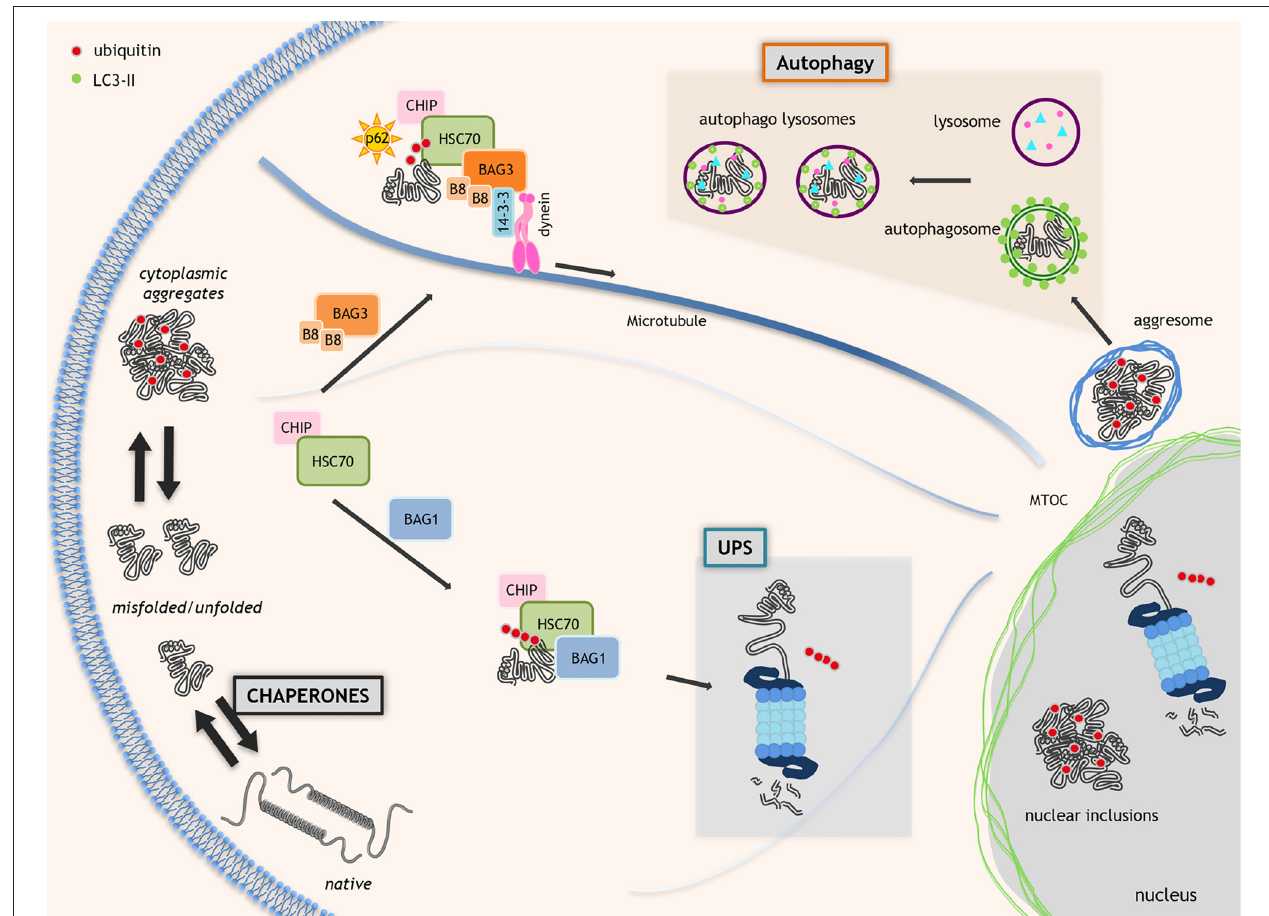
FIGURE 1 | Proteostasis in neurodegenerative disorders. Molecular chaperones assist proteins to acquire the proper folding. When folding fails, the chaperones allow the ubiquitination and route misfolded proteins to degradative systems. This process is mediated by the HSC70-CHIP complex that interacts with nucleotide exchange factor (NEF)/BCL2-associated athanogenes (BAGs; HSC70 co-chaperones). BAG1 routes misfolded proteins to ubiquitin proteasome system (UPS). Alternatively, BAG3 and specific chaperone heat shock protein B8 (HSPB8; B8 in the figure) promote the degradation of HSC70 substrates via autophagy. The HSC70-CHIP interaction with BAG1 inhibits the HSP70 chaperone activity and allows misfolded proteins polyubiquitination by HSC70-binding co-factor CHIP resulting in misfolded proteins degradation via UPS. BAG3 interacts with dynein and 14-3-3 protein moving misfolded proteins to microtubule organization center (MTOC) where aggresomes are assembled. Polyubiquitinated proteins linked to HSC70-BAG3 are recognized by SQSTM1/p62 and its interaction with LC3 allows misfolded proteins insertion into